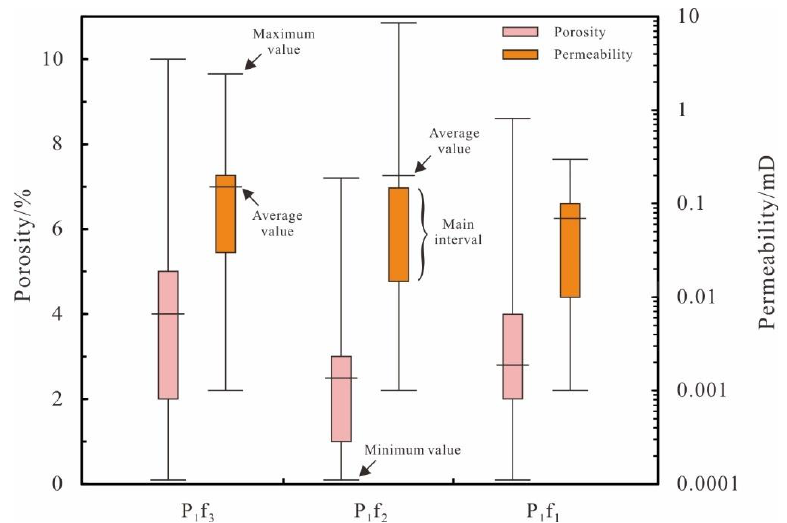
Figure 5. Distribution of porosity and permeability parameters of the Fengcheng Formation in the Mahu Sag.